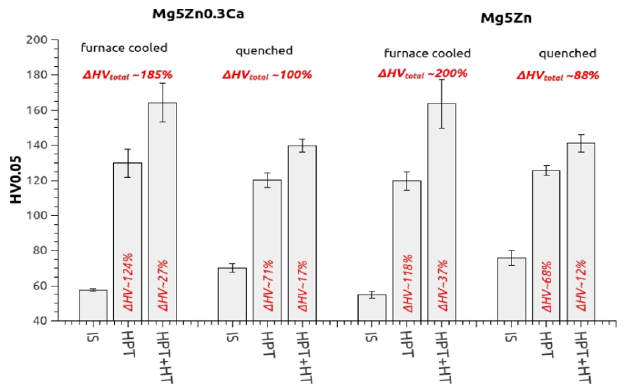
Figure 11. Total microhardness increases of Mg5Zn0.3Ca and Mg5Zn in the IS (furnace ‐ cooled and quenched) and additional HPT deformations after 4 GPa and 0.5 rotations and additional heat treatment at 100 °C for 24 h.